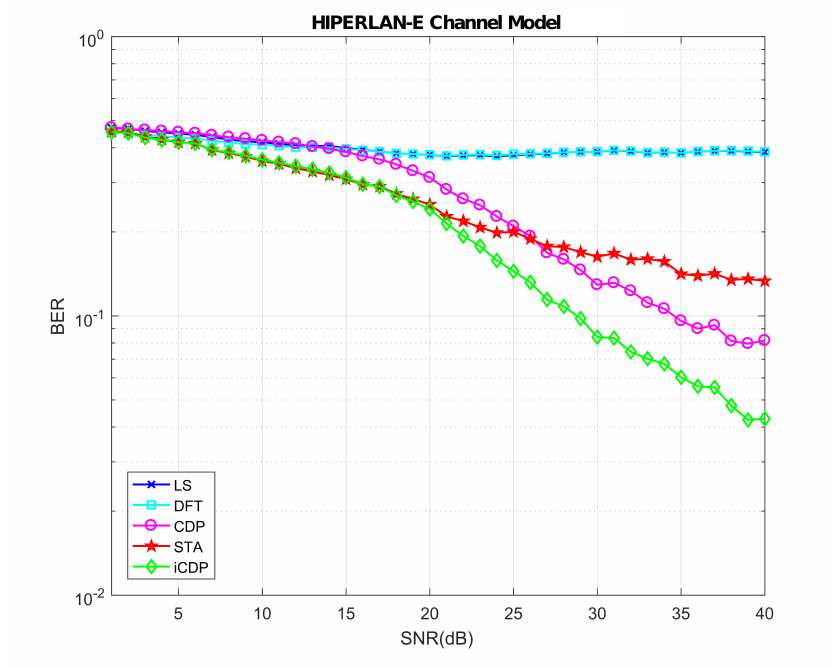
Figure 8. HIPERLAN-E channel model with Data Symbols =